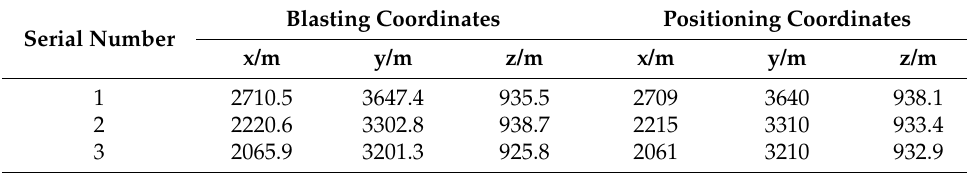
Table 4. Blasting point positioning coordinates.